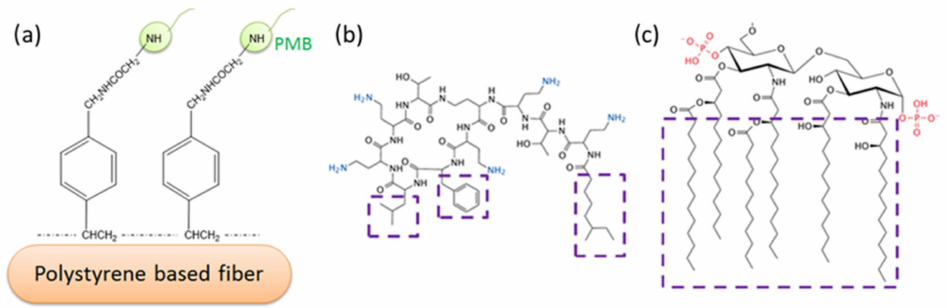
Figure 1. Typical PMB-immobilized polystyrene-based fiber system ( a ); proposed interaction mech- anism of PMB ( b ) and Lipid A of LPS ( c ). Ionic interaction of amino groups in PMB (in blue) and phosphate groups in Lipid A (in red); Van der Waals’ interaction between hydrophobic regions of PMB and Lipid A (in purple